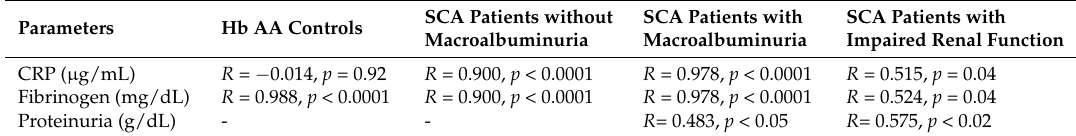
Table 3. Correlation between NLR and other inflammatory markers in SCA patients and controls.